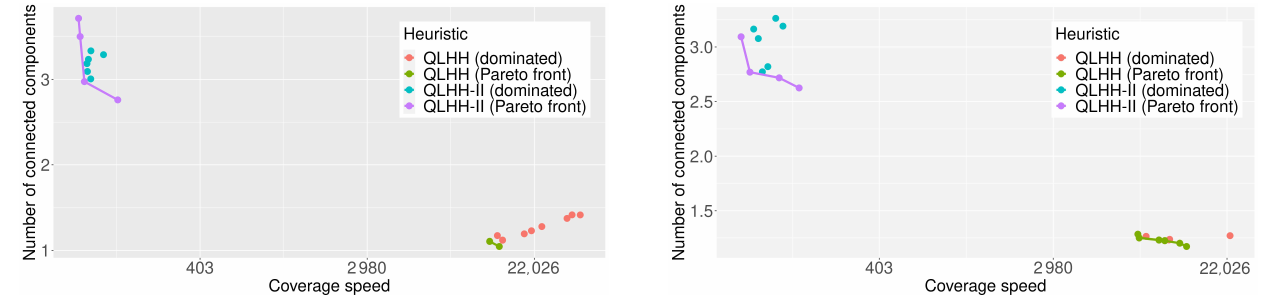
Figure 8. Solutions obtained with heuristics generated by QLHH and QLHH-II on two instances (the x -axis uses a logarithm scale due to the huge gap between